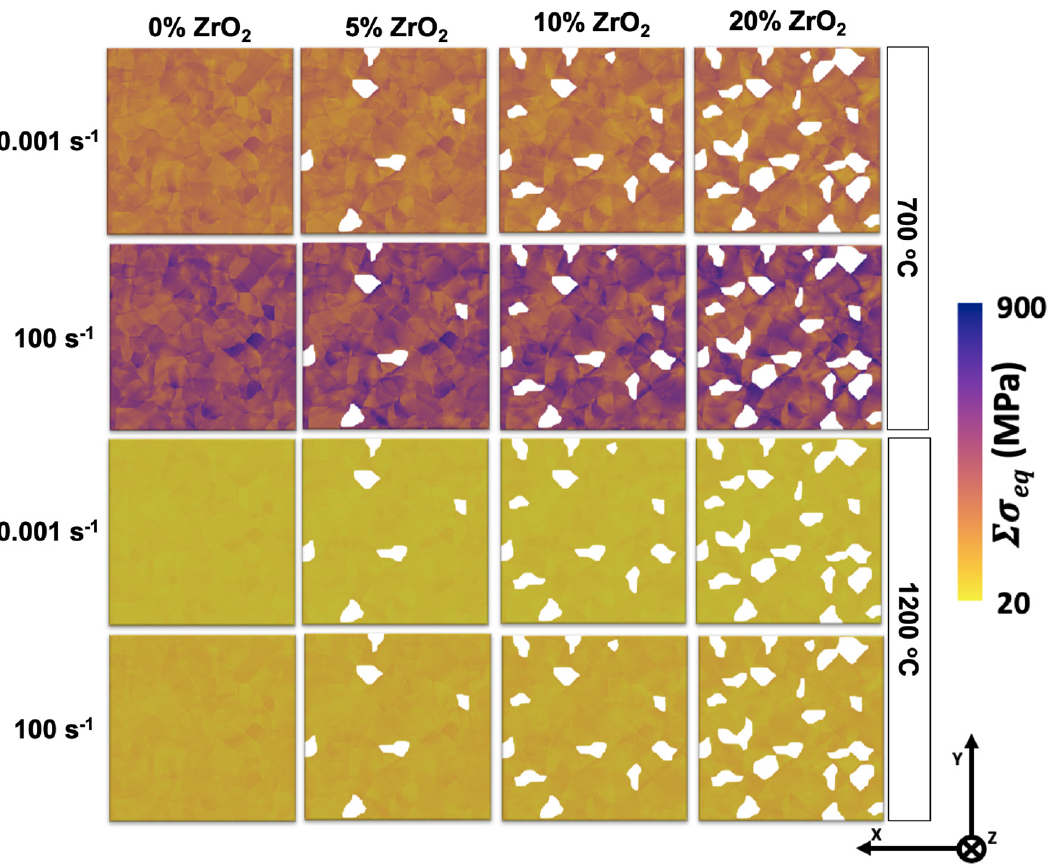
Figure 9. Local stress distribution maps at true strain and 700 and 1200 ◦ C for strain rates of 0.001 and 100 s − 1 . The stress distribution became heterogeneous after the zirconia particles were included, and the stress concentration was higher at the zirconia/austenite interface. The stress distribution in the whole matrix was non-uniform, as some grains had high stress and some had very low stress.